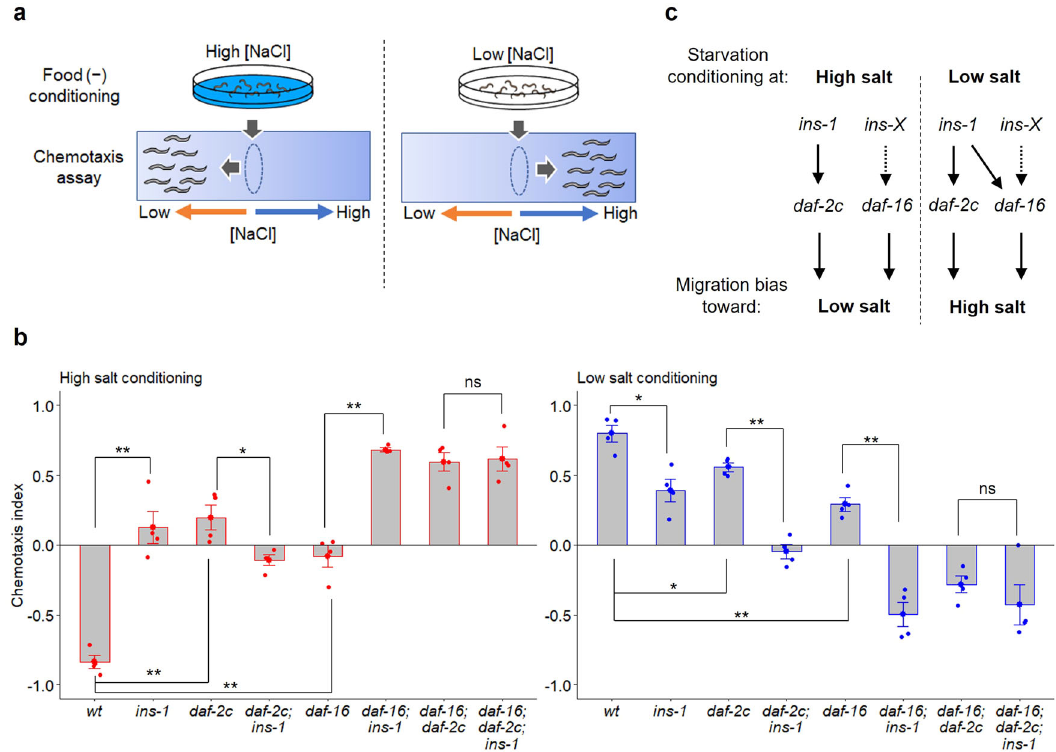
Fig. 1 INS-1 acts in both DAF-2c and DAF-16 pathways in taste avoidance learning. a Schematic of taste avoidance learning. b Salt chemotaxis after conditioning on agar plates at high or low salt concentrations in the absence of food. A chemotaxis index was determined according to the following equation: Chemotaxis index = ( N A − N B )/( N all − N C ), where N A and N B are the number of worms in the high- and low-salt areas, respectively, N all is the total number of worms on a test plate, and N C is the number of worms in the area around the starting position. Positive and negative chemotaxis indices mean migration toward high and low salt, respectively. Each dot in red or blue represents a chemotaxis index calculated in each chemotaxis assay after conditioning at high or low salt concentrations, respectively. n = 4 assays. Bars represent mean values; error bars represent SEM. Two-tailed Welch ’ s t-test with Holm correction: * P < 0.05 and ** P < 0.01. ns not signi fi cant. c Proposed genetic pathways downstream of ins-1 in the regulation of low- or high-salt migration after high- or low-salt conditioning in the absence of food,